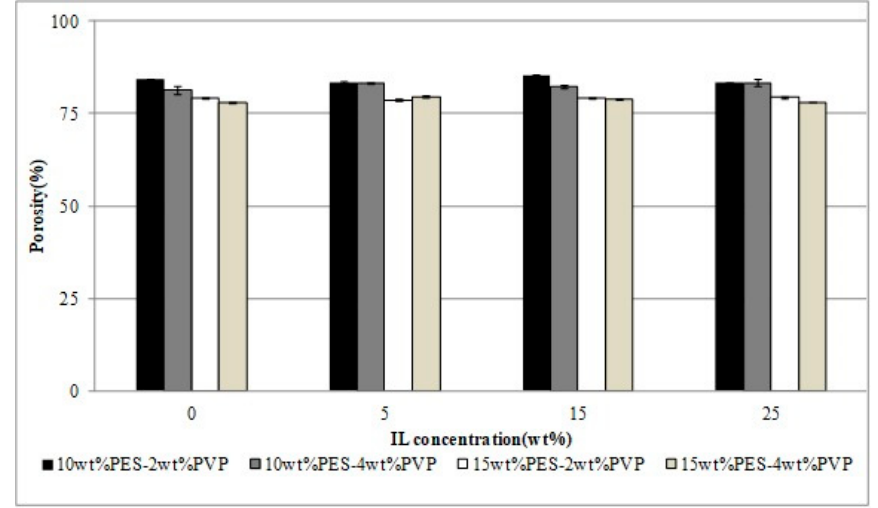
Figure 10. Porosity of PES membrane as a function of PVPK17 concentration [56].